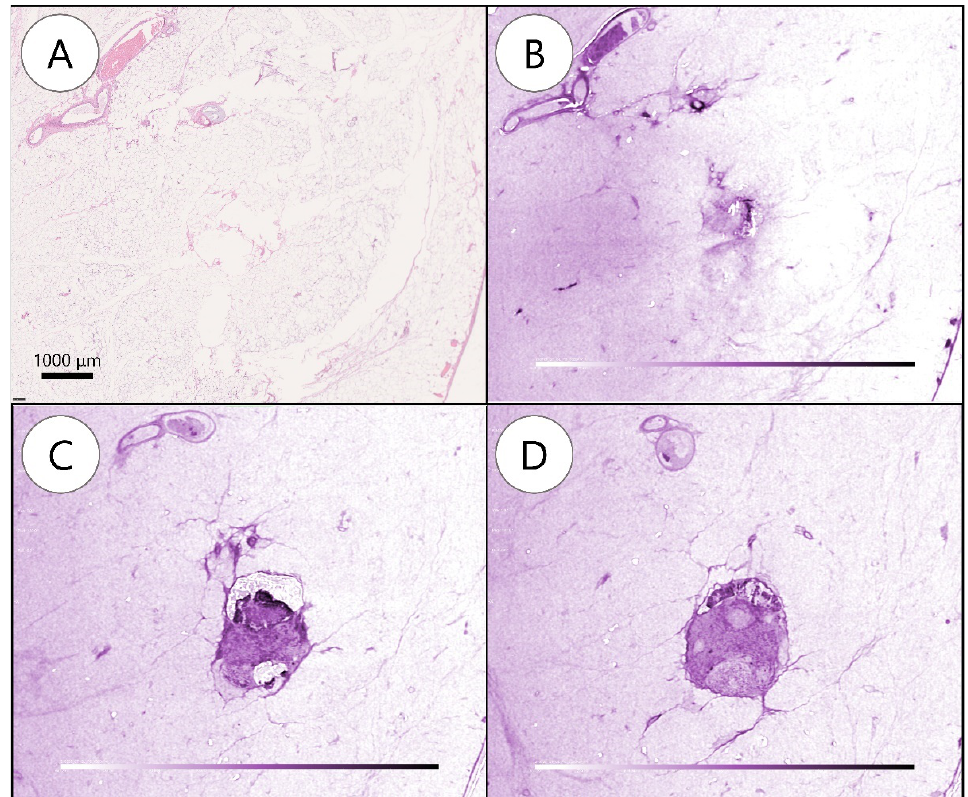
Figure 3. Metastatic lymph node detected by whole-block imaging. ( A ) Metastatic lymph node (MLN) not noted on hematoxylin and eosin slide. ( B ) MLN not noted on whole-block image. ( C ) Serial images showing subcapsular transparency and clusters of cells. ( D ) Structural irregularities, space-occupying lesions, and density differences deeper in ( C ).